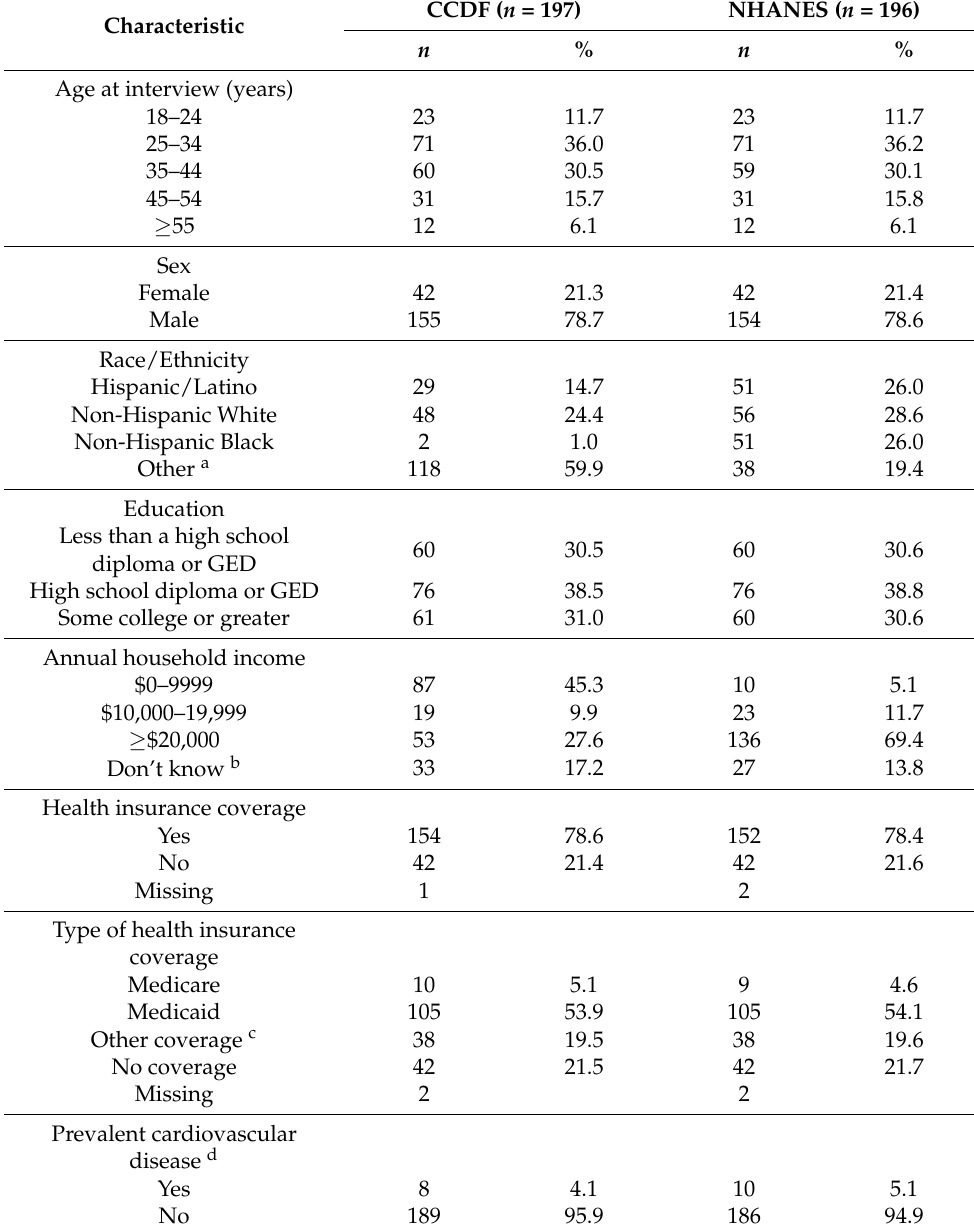
Table 2. Characteristics of individuals incarcerated in Coconino County Detention Facility and matched NHANES participants,